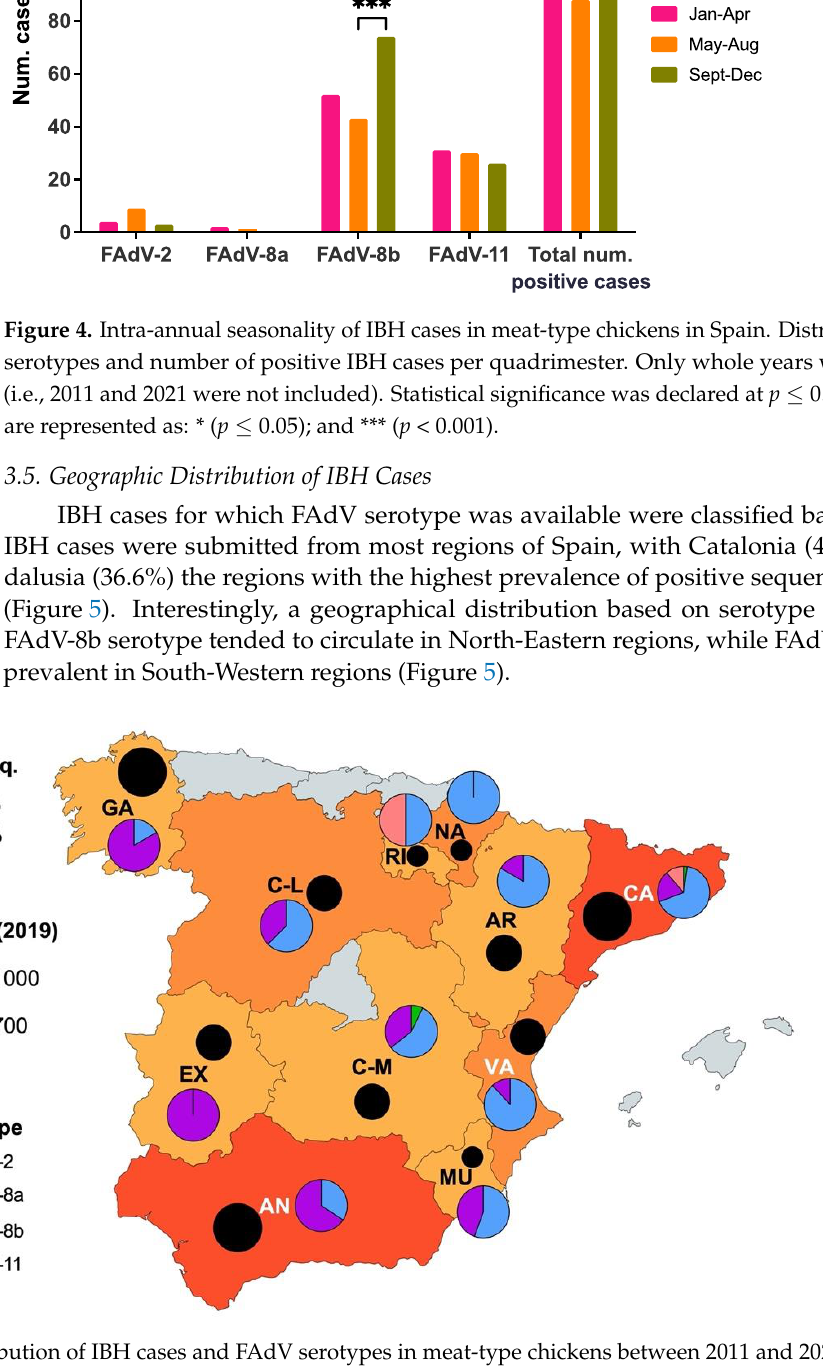
Figure 5. Geographic distribution of IBH cases and FAdV serotypes in meat-type chickens between 2011 and 2021 in Spain. The colors correspond to the percentage of FAdV-positive sequenced samples from each region. The pie charts indicate the percentage of FAdV serotypes in each region. The black circles indicate the number of meat-type poultry farms in each region according to the 2019 census [18].